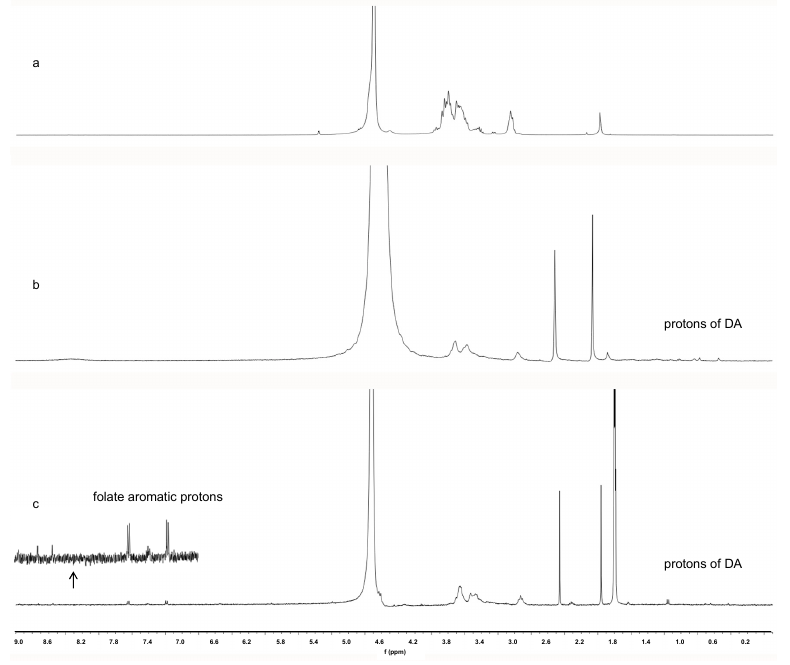
Figure 2. 1 H-NMR spectra of ( a ) CS, ( b ) CS-DA and ( c )